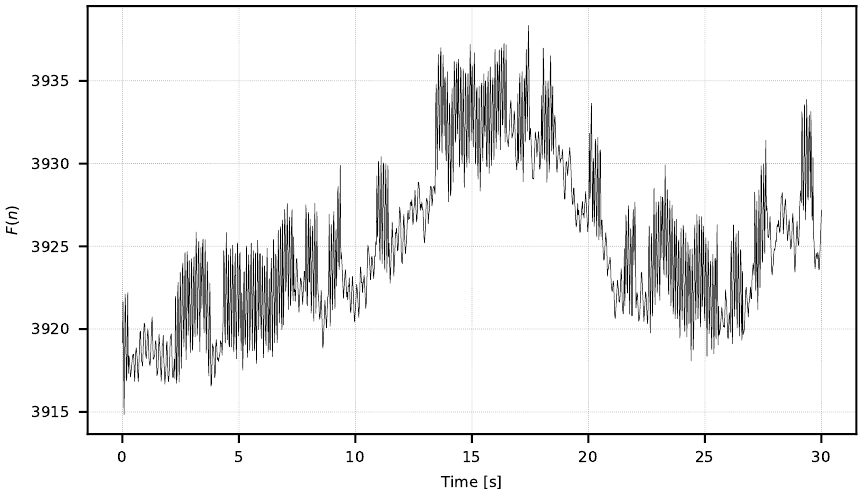
Figure 6. Exemplary F signal exhibiting strong 1/f